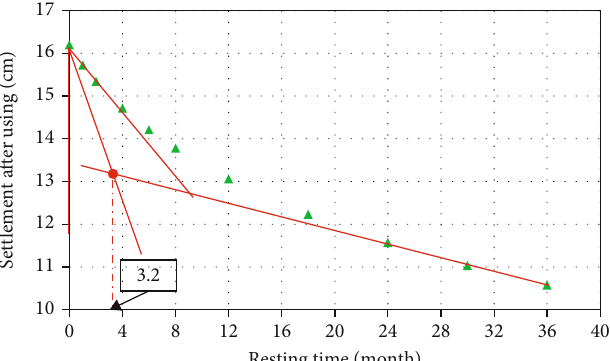
Figure 17: The relationship between settlement after 15 years of using and resting